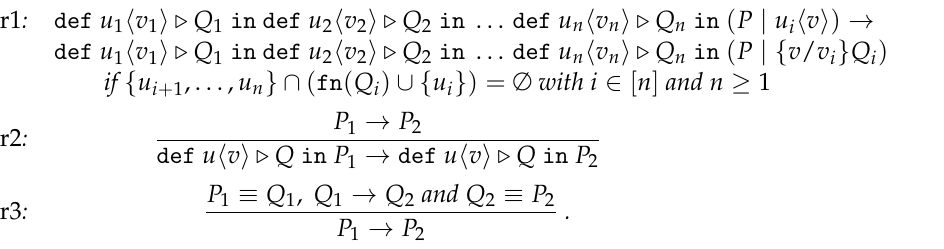
Figure 1. The left representation uses only lines of non-zero length, while the right one uses only lines of zero length. The representation in the middle is a compromise (between lengths) to provide a reasonable picture.